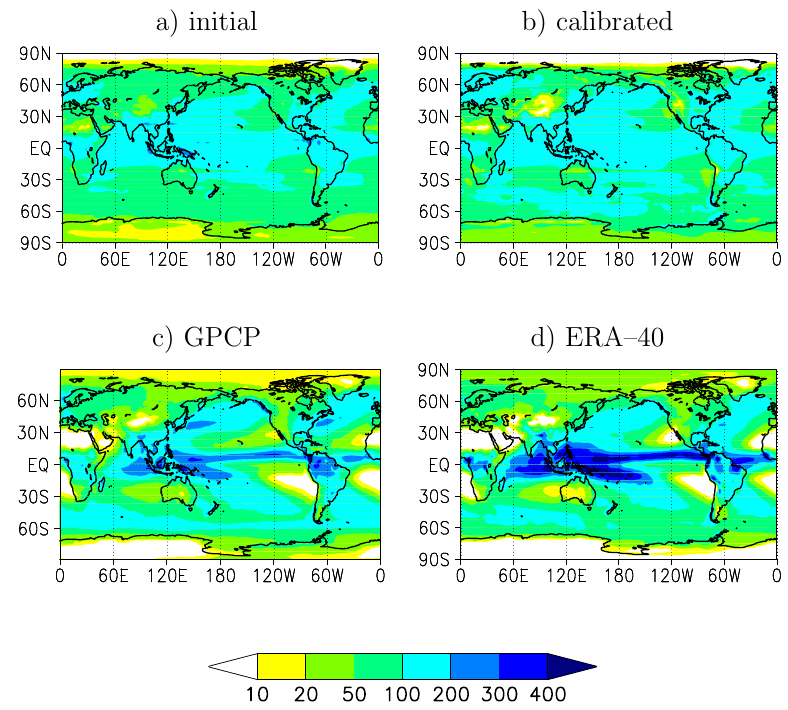
Fig. 11. Annual modelled total precipitation (cmyr − 1 ) for initial and calibrated parameter sets ( a and b , respectively) in comparison to the GPCP and ERA-40 climatologies ( c and d ).